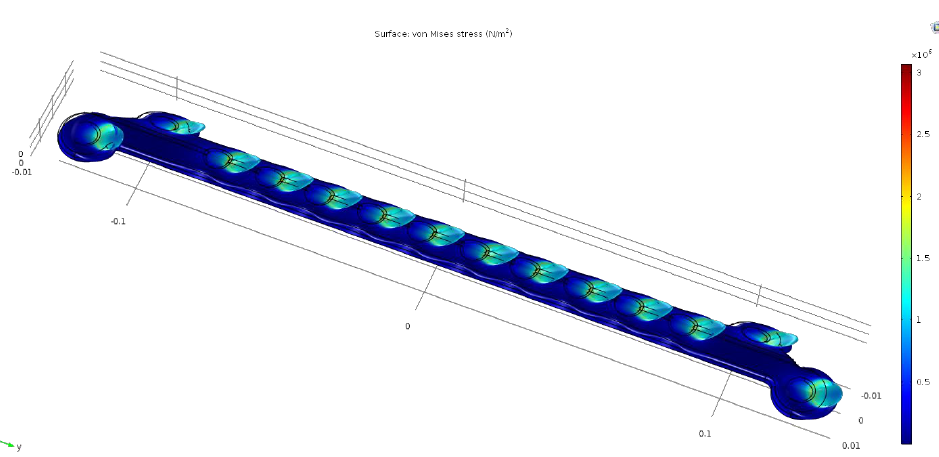
Figure 18. Total displacement of newly developed plate bent for 30 ◦ .